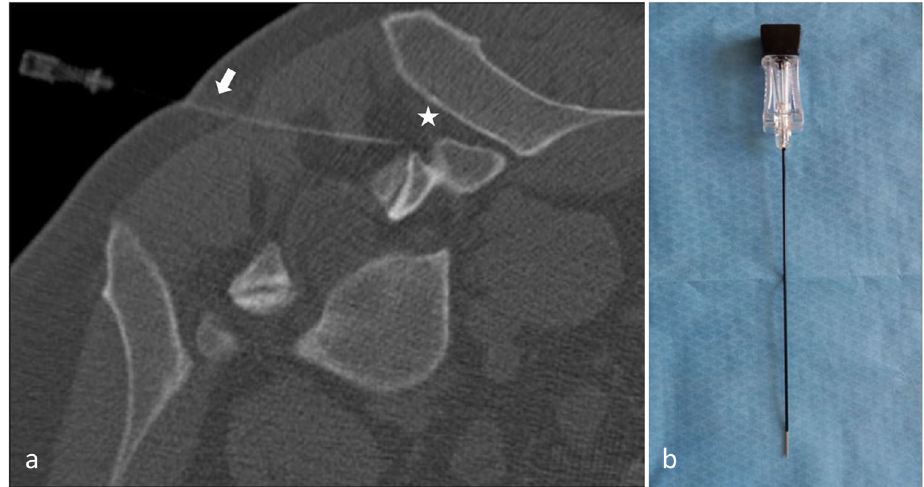
radiofrequency ablation. a : Radiofrequency ablation at the right L5-S1 level. Appropriate electrodeplacement(whitearrow) parallel to the target nerve (white star) in order to achieve denerva- tion along a substantial segment of the targeted nerve. b : 22G